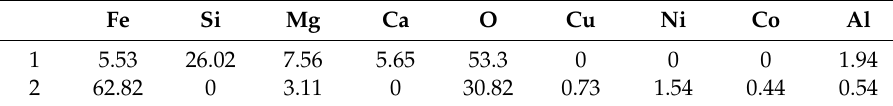
Table 3. Elemental composition of the oxidized slag (wt%).